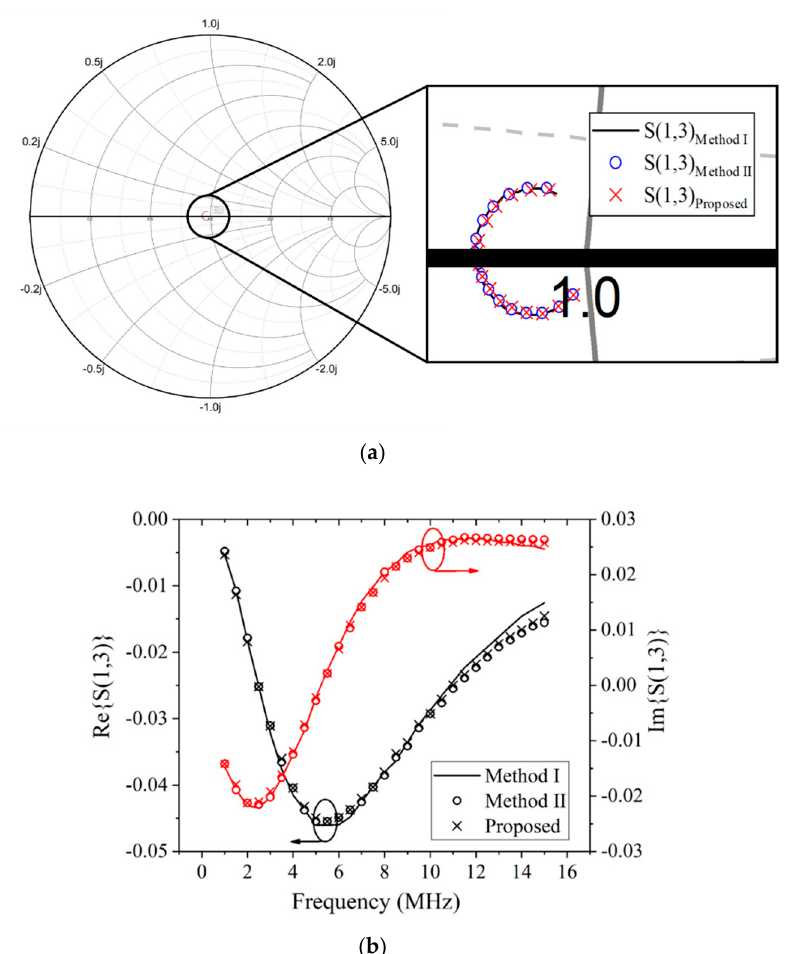
Figure 9. S parameter results for three coils from the proposed and conventional methods at 8 cm: ( a ) Smith chart form and ( b ) real and imaginary values.